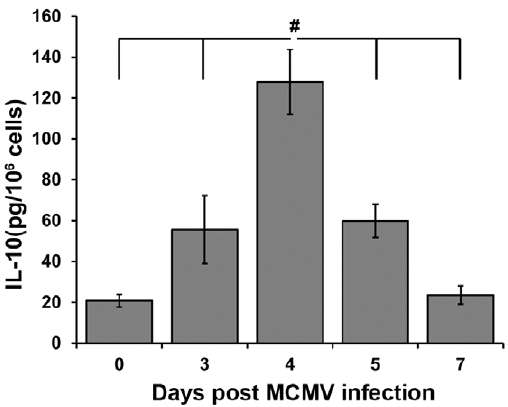
Figure 1. IL-10 production by liver leukocytes after MCMV infection. Liver leukocyte conditioned media were prepared from the livers of C57BL/6J mice that were uninfected (0) or infected with MCMV for 3, 4, 5, and 7 days. Concentration of IL-10 protein in liver